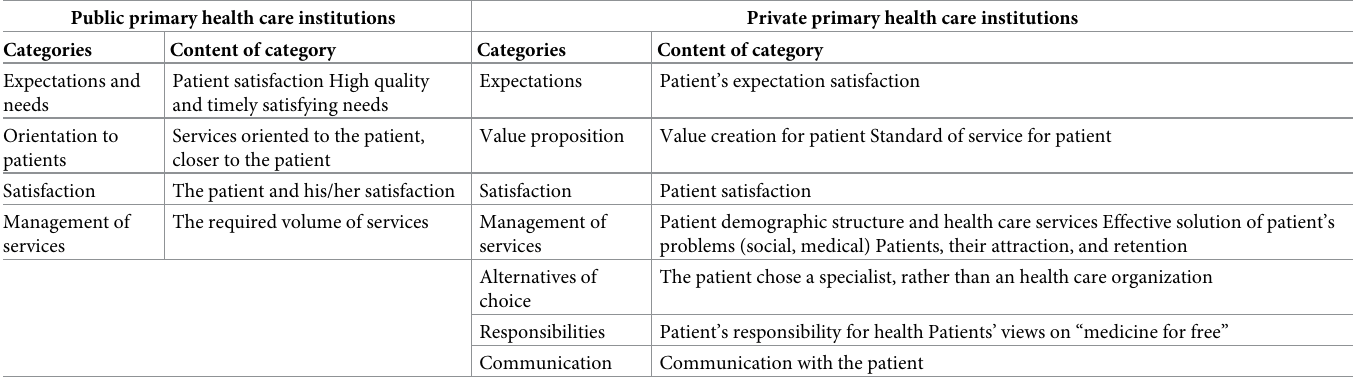
Table 4. Categories of “management of patients”